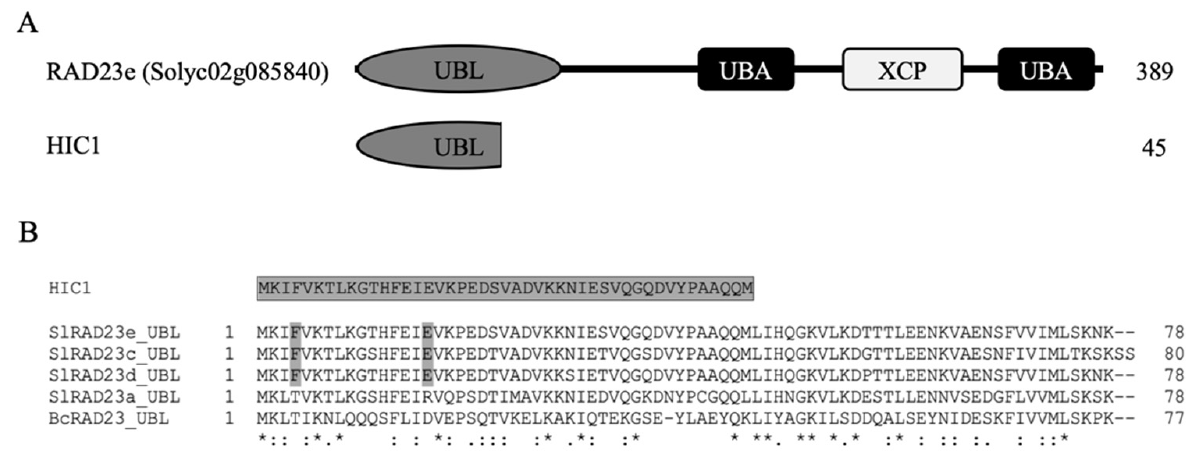
Figure 1. Sequence analysis of the HPE1 interacting clone, HIC1, identified in yeast two-hybrid screening. ( A ) Protein structure of the HIC1 and its full-length encoding protein, RAD23e. ( B ) Amino acid sequence alignment of the ubiquitin-like domain (UBL) of RAD23 proteins from Solanum lycoperisicum and Bactericera cockerelli . Asterisk, colon and dot denote the conserved and similar amino acid residues.